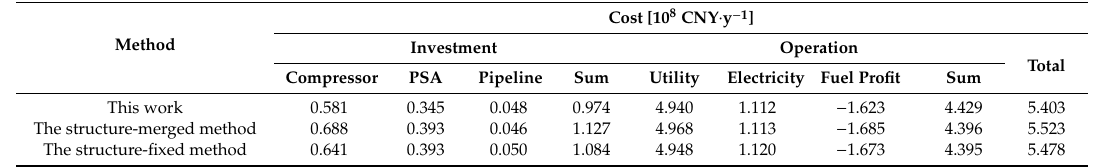
Table 9. Comparison of costs of design schemes obtained by the three methods.